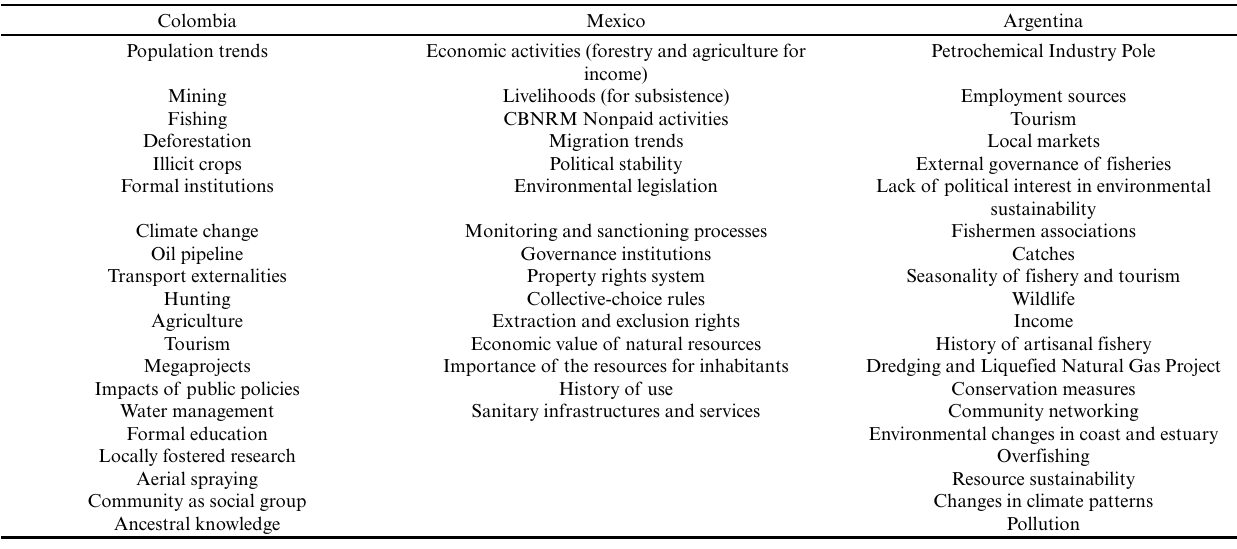
Table 3 . List of variables selected in each social-ecological systems (SES).